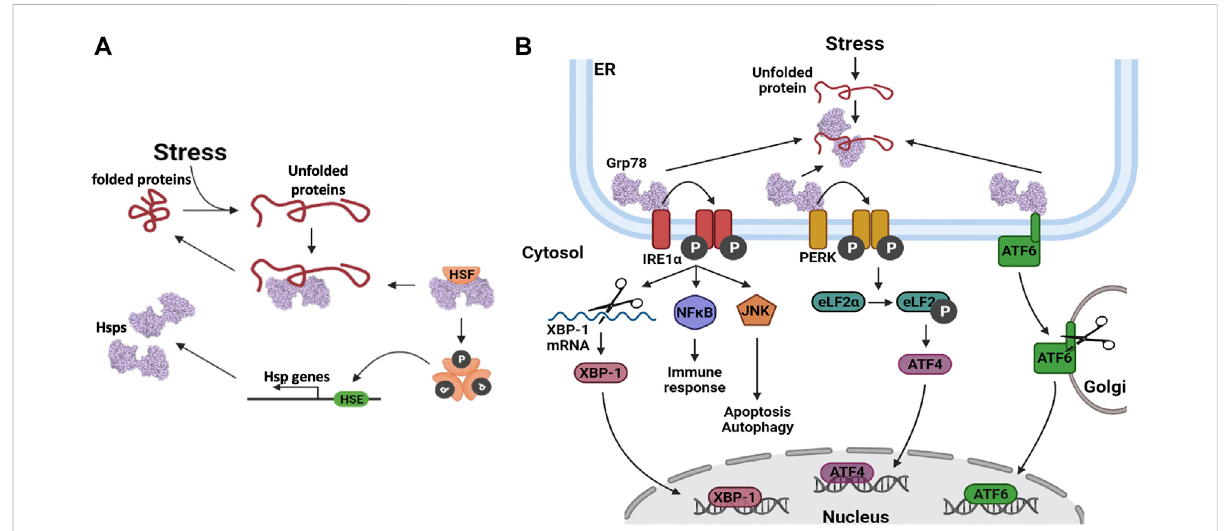
FIGURE 4 Heat shock protein expression regulation. (A) Upregulation of Hsp gene transcription. When unfolded proteins accumulate in the cell, Hsps dissociate from their bound heat shock factors (HSF). This frees up the Hsps to assist in protein folding and it also activates the HSF. The HSFs are phosphorylated,afterwhichtheyoligomerize.TheHSFsbindtoheatshockelements(HSE)inthepromoterregionsofHspgenes,therebyenhancing their transcription. (B) Hsp gene transcription is upregulated via three distinct pathways involving three distinct transcription factors (TFs); Inositol requiring enzyme 1 α (IRE1 α ), protein kinase RNA-like endoplasmic reticulum kinase (PERK) protein and activating transcription factor 6